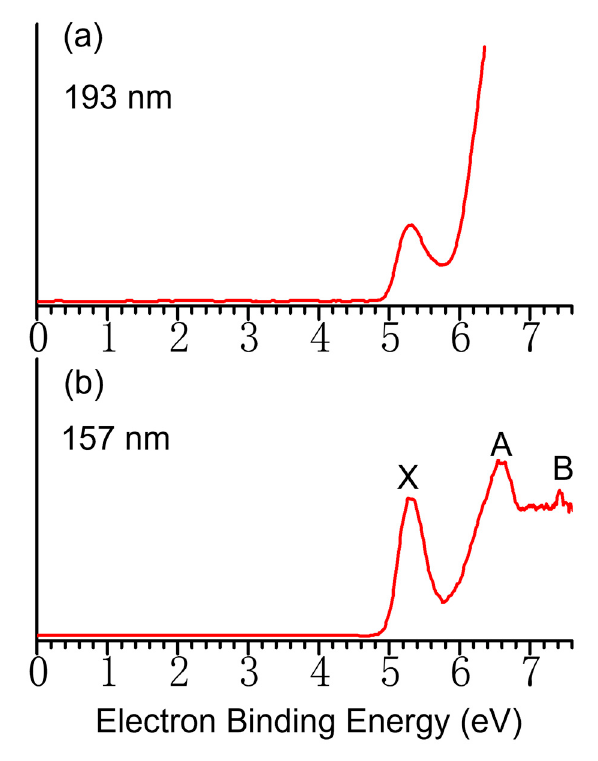
Figure 1. The 20 K NIPE spectra of the cysteine perthiosulfonate anion [cysS-SO 3 ] − at ( a ) 193 nm (6.424 eV) and ( b ) 157 nm (7.867 eV).